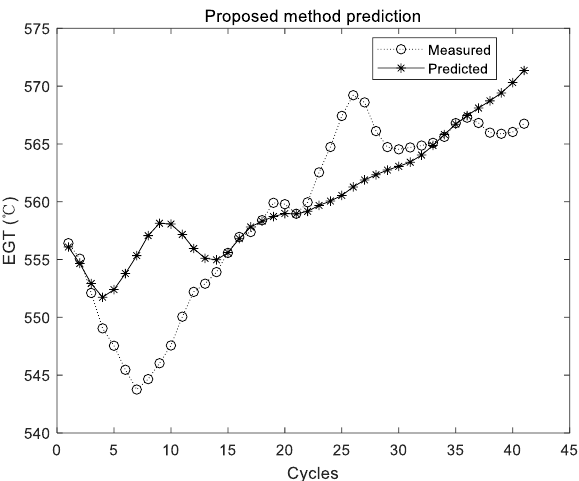
Figure 11. Experimental results of the proposed method using the first group of data.